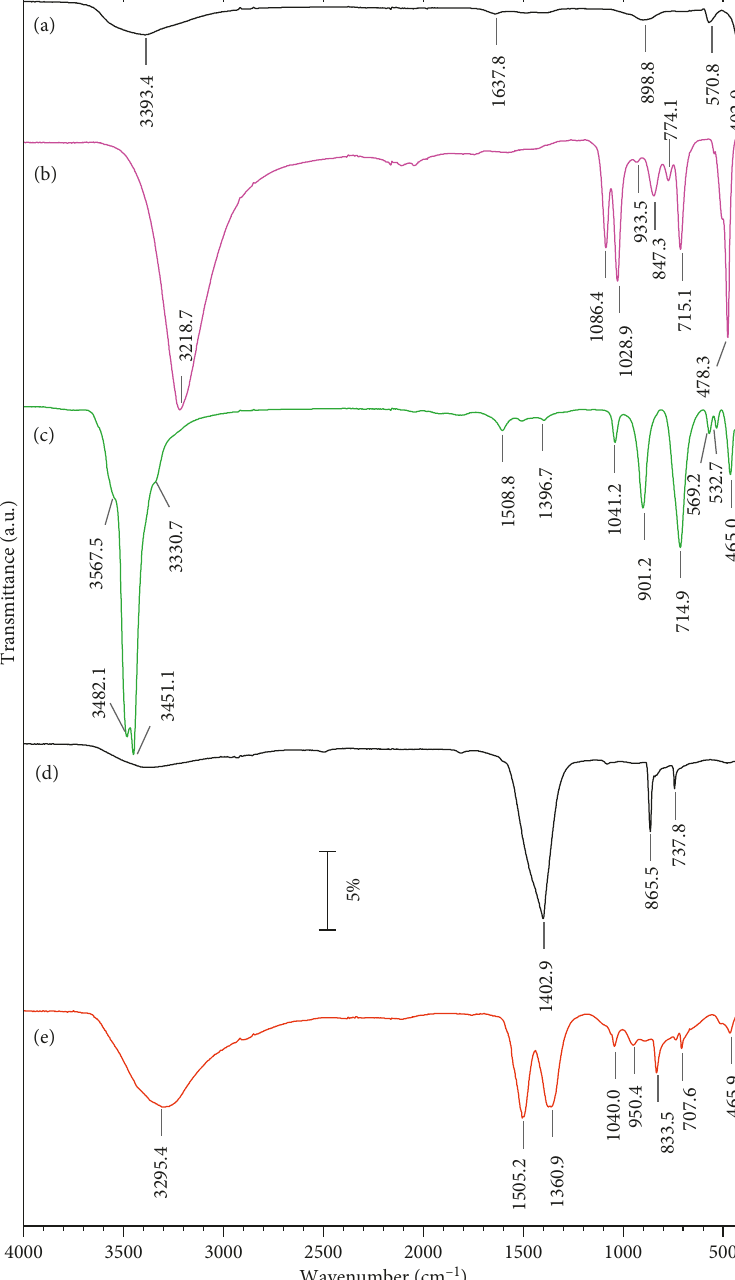
Figure 4: FT-IR ATR spectra of ZnO (a), Zn(OH) 2 (b), Zn 5 (OH) 8 Cl 2 · H 2 O (c), ZnCO 3 (d), and Zn 5 (CO 3 ) 2 (OH) 6 (e) powders prepared by the precipitation